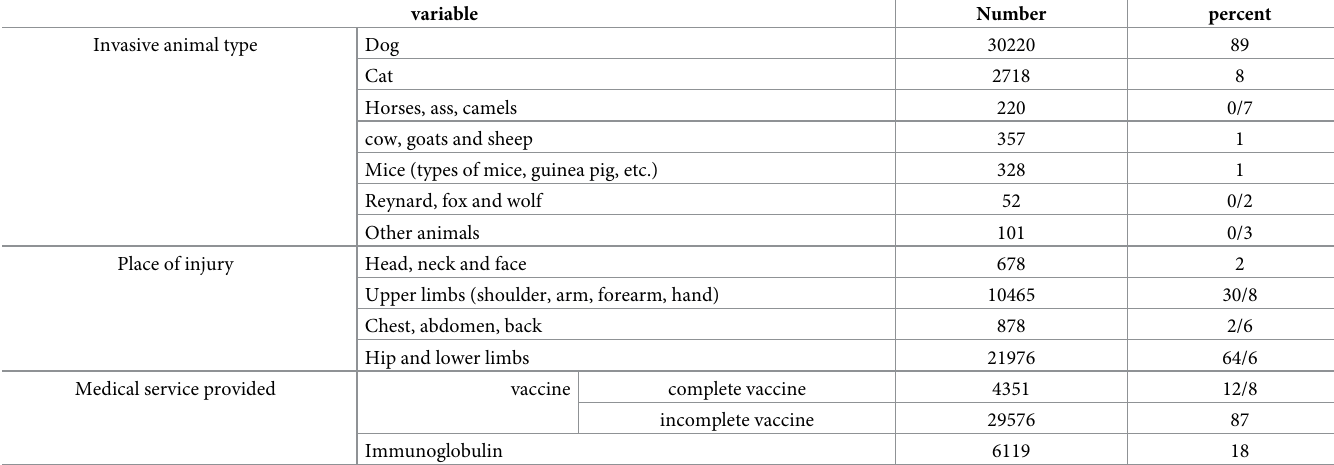
Table 3. Information on the type of invading animal, place of the injury, and medical services